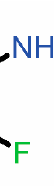
Figure 4. Two-dimensional structure of flucytosine used as an antimetabolite agent against invasive fungal infections. fungal